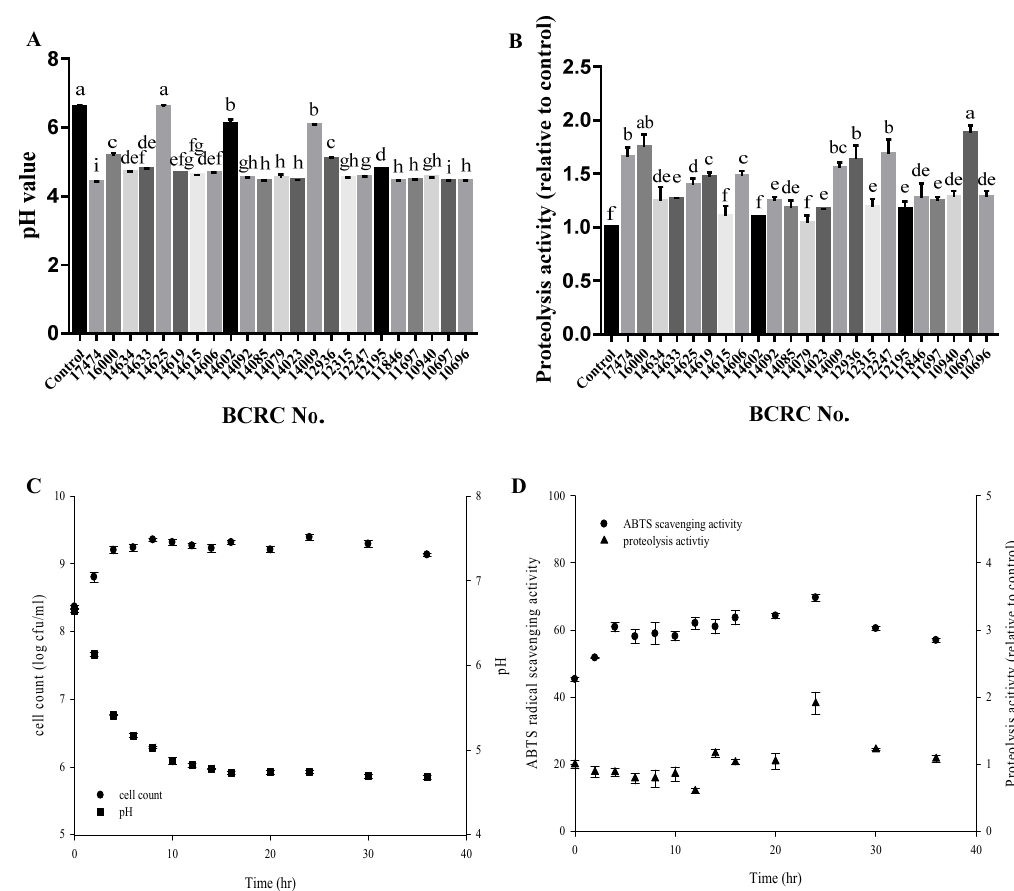
Figure 1. The selection of different lactic acid bacteria for djulis fermentation through the determination of ( A ) the pH value and ( B ) proteolysis activity of djulis fermented by different LAB strains. ( C ) Growth curve and ( D ) ABTS radical scavenging activity and proteolysis activity of djulis fermented by L. casei BCRC 10697. Values are the mean ± SD. Superscripts (a, b, c, etc.) indicate significant differences in Fisher’s LSD tests ( p < 0.05).